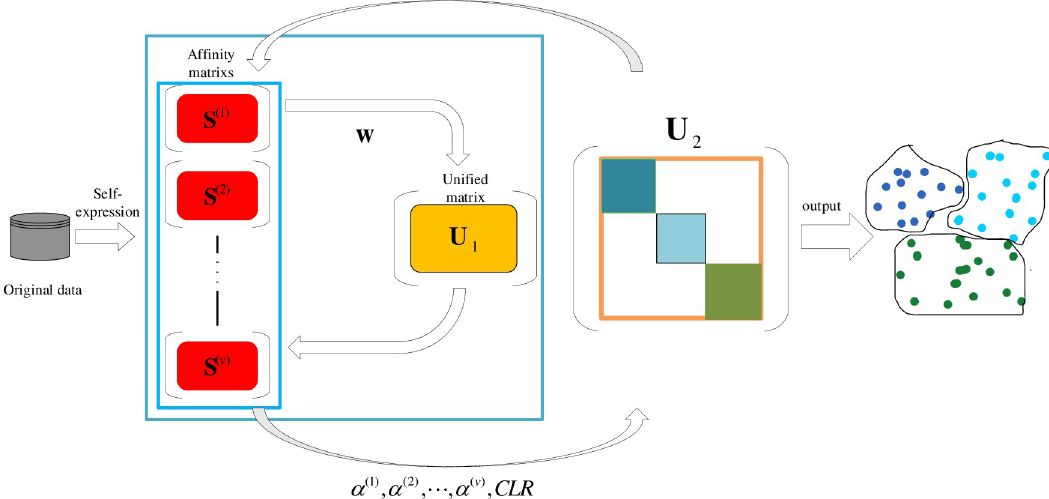
Fig 1. The RMVCP process without tissue-like P system.